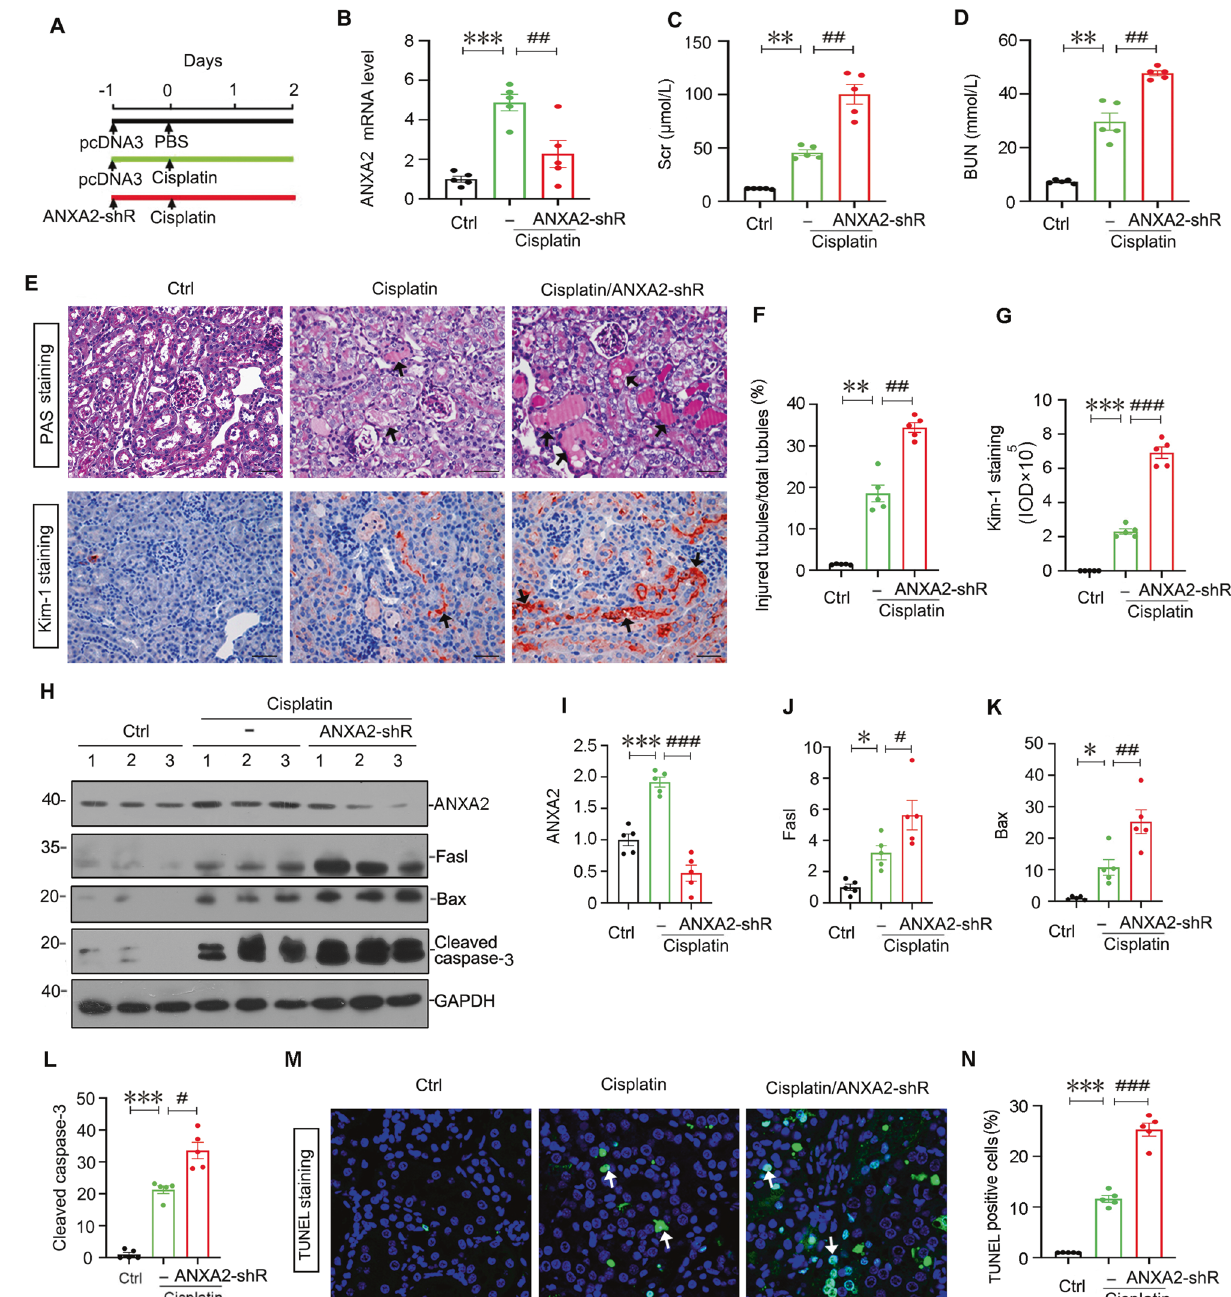
Fig. 5 Knockdown of ANXA2 worsens AKI in vivo. A The schematic graph shows the experimental design. B The quantitative data shows the mRNA levels of ANXA2. *** P < 0.001 versus Ctrl ( n = 5); ## P < 0.01 versus cisplatin alone ( n = 5). The quanti fi cations of Scr ( C ) and BUN ( D ) levels in 3 groups are shown. ** P < 0.01 versus Ctrl ( n = 5); ## P < 0.01 versus cisplatin alone ( n = 5). E – G Representative photographs show PAS and Kim-1 staining and their quanti fi cations. Scale bars, 50 μ m. In PAS staining, arrows indicate severely injured renal tubules with naked brush boarder; In Kim-1 staining, arrows indicate positive staining. Scale bar, 50 μ m. ** P < 0.01, *** P < 0.001 versus Ctrl ( n = 5); ## P < 0.01, ### P < 0.001 versus cisplatin alone ( n = 5). Representative western blotting ( H ) and quanti fi cations show the expression of ANXA2 ( I ), Fasl ( J ), Bax ( K ) and cleaved caspase-3 ( L ).* P < 0.05, *** P < 0.001 versus Ctrl ( n = 5); # P < 0.05, ## P < 0.01, ### P < 0.001 versus cisplatin alone ( n = 5). Representative photos show TUNEL-positive cells ( M ) and its quanti fi cation ( N ). Scale bar, 50 μ m. *** P < 0.001 versus Ctrl ( n = 5); ### P < 0.001 versus cisplatin alone ( n = 5). Abbreviations: ANXA2 annexin A2, Ctrl control, pcDNA3 empty vector; shRNA small hairpin